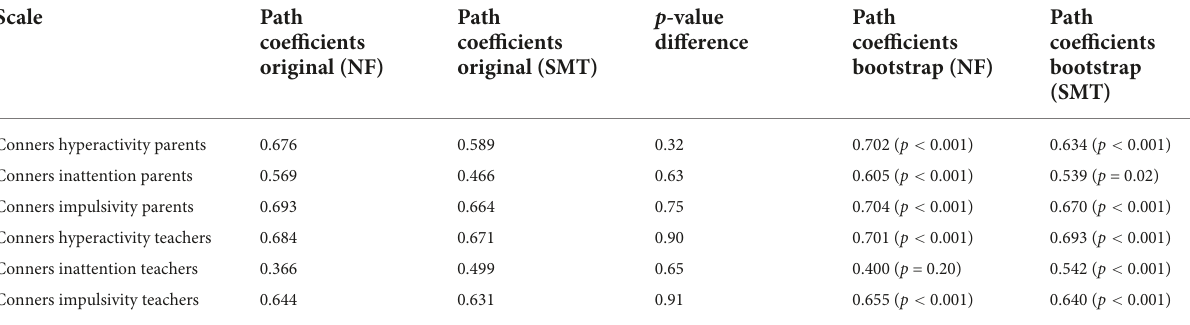
TABLE 3 Original path coefficients of Conners subscales in parents and teachers in NF ( n = 55) and SMT ( n = 58) after imputing missing values with k-nearest neighbor (kNN) algorithm.